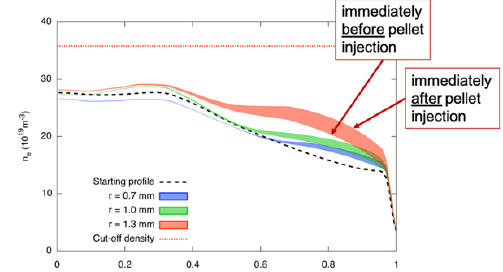
Fig. 5 . Density profiles of the JINTRAC simulations without (dashed) and with pellets (coloured: blue for radius of 0.7 mm, green for 1 mm, red for 1.3 mm. The bottom and top sides of every band represent the profile immediately before and after one pellet). Density cut-off for Ordinary mode is represented by red dashed